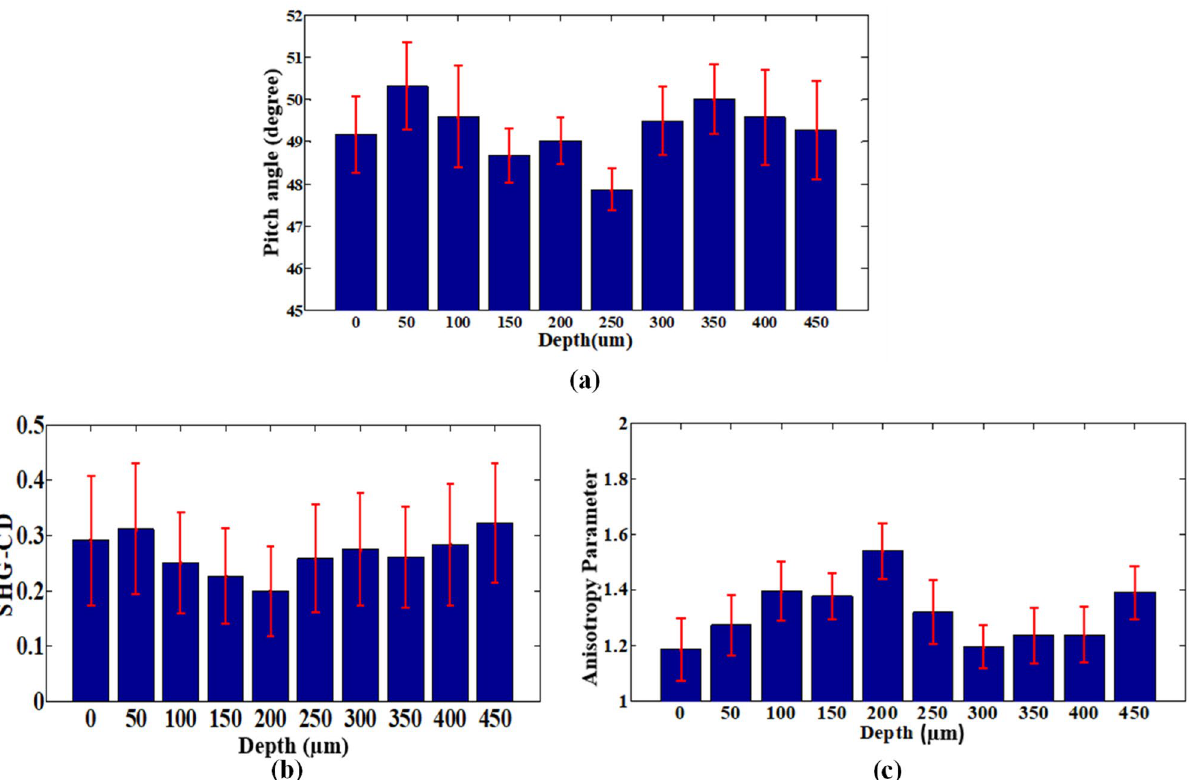
Figure 6. Mean bar graphs for ( a ) PA, ( b ) SHG-CD, and ( c ) AP response of collagen at increasing depth of articular cartilage (0–500 μm). Error bars represent standard error of mean. All the bar graphs were generated by using MATLAB R2019a (Version: 9.6.0.1072779, https:// www. mathw orks. com/ produ cts/ new_ produ cts/ relea se201 9a.